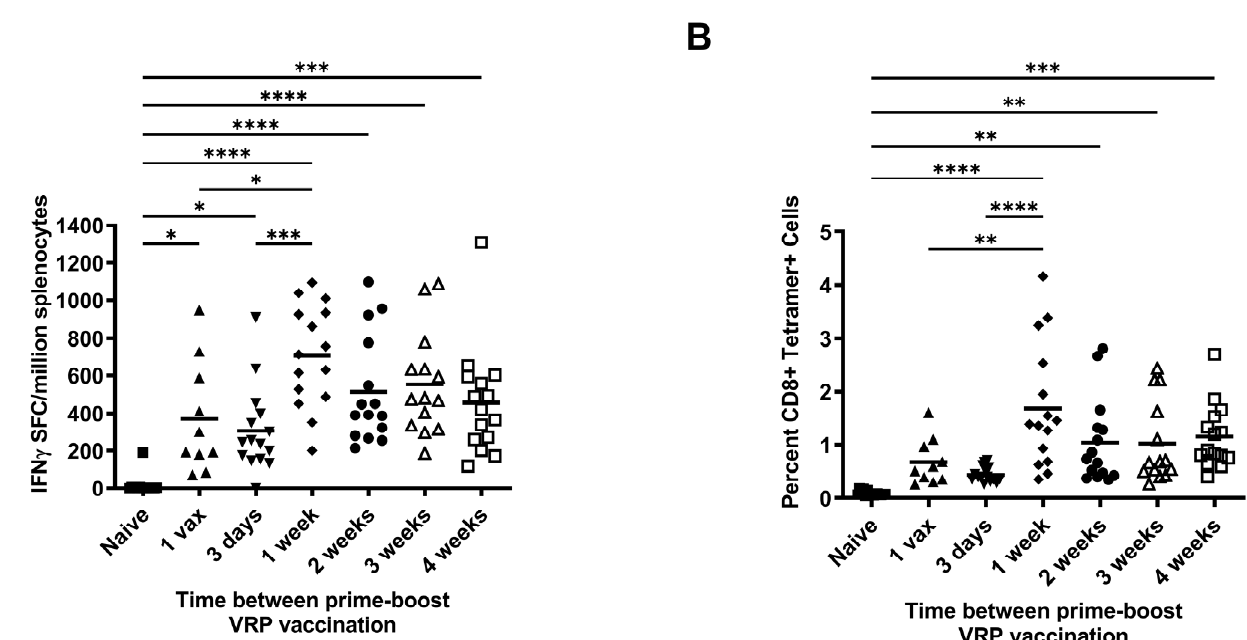
Figure 2. Ex vivo analysis of T-cell response after different prime-boost intervals. C57BL/6 mice ( n = 5/group per experiment) were immunized i.m. with 1 × 10 7 IU HPV16 E7E6 VRP according to the vaccination schedule in Figure 1. ( A ) HPV16 E7-specific IFN γ secretion by ELISpot assay. Shown are the number of spot-forming cells (SFC) per million splenocytes for each mouse from three inde- pendent experiments with the mean indicated by the horizontal bar. Mean SFC from all vaccinated mice were significantly increased compared to naïve mice (range of p < 0.05 to p < 0.0001, one-way ANOVA). ( B ) Splenocytes were tested for binding of H2-D b MHC tetramers loaded with HPV16 E7 (49–57) peptide. Shown is the percentage of E7 tetramer-binding CD8 + T cells for each group of mice from three independent experiments with the mean indicated by the horizontal bar. Mice vaccinated at 4 wk, 3 wk, 2 wk, and 1 wk prime-boost exhibited a greater mean number of E7 tetramer positive CD8 + T cells compared to naïve mice (range of p < 0.01 to p < 0.0001). ( C ) In vivo cytotoxicity assay. Naïve C57Bl/6 splenocytes were loaded with E7 (49–57) peptide or irrelevant control D b -binding